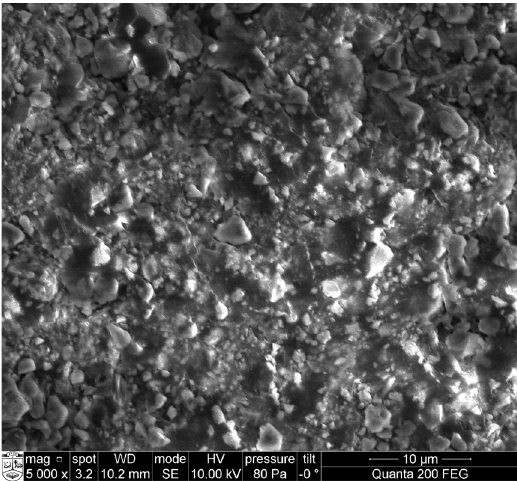
Figure 1: Typical SEM micrograph of additive Granic 422 before application for manufacture of tapes.